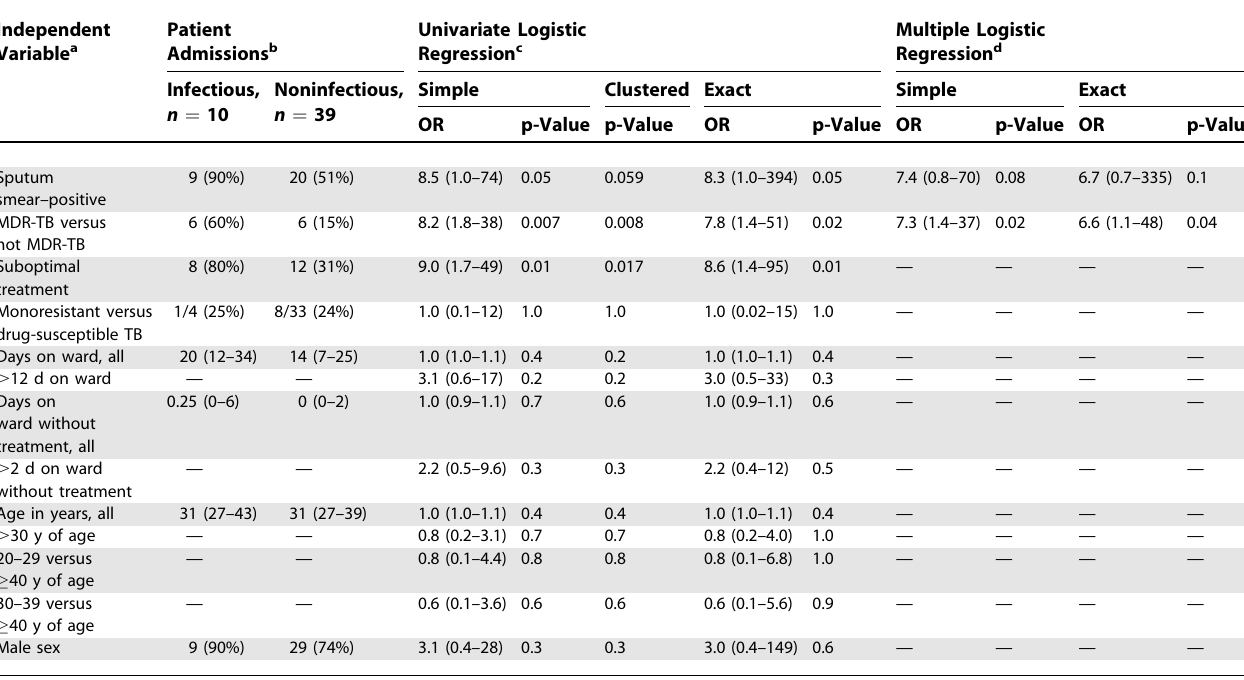
a For categorical independent variables, the number of cases (% of total in parentheses) is shown, and for continuousindependent variables, the median (IQR in parentheses) is shown. The primary analysis treated the independent variables ‘‘ Days on Ward ’’ and ‘‘ Days on Ward without Treatment ’’ and ‘‘ Age ’’ as raw, continuous variables. These primary analyses are complementedby secondaryanalyses (in parentheses)of eachof these variablesdividedinto categories aroundcutoffpointschosen to maximizethe likelihoodof theoutcome. Notethat the analysis of these independent variables as continuous or categorical data gave similar results. b Regression analysis was performed on putative determinants of infectiousness for the 49 ward admissions by pulmonary TB patients for which spoligotype patterns were available. Four patients accounted for the ten multiple admissions in this group. The first had MDR TB and was infectious on one admission when inadequately treated, and non-infectious on a subsequent admission when adequately treated. The second had four admissions: three were noninfectious with drug-susceptible TB that was first smear-positive and then smear- negative. The fourth admission was infectious, with acquired MDR-TB. The third patient had two noninfectious admissions separated by 4 mo with smear-positive inadequately treated monoresistant TB. The fourth patient had two noninfectious admissions separated by two months with smear-negative drug-susceptible TB. c The simple univariate regressions are shown with robust clustered SE estimated (to account for repeated hospitalizations by some patients) and with exact logistic regression (to account for the sample size). Note that simple, clustered, and exact univariate logistic regressions gave similar results. ORs (95% confidence intervals) are included. d Because of the sample size, only the three independent variables with clear associations with infectiousness (sputum-smear, MDR TB and suboptimal treatment) were considered for multiple regression analysis. In both simple and exact multiple logistic regression, the bestmodel by AIC criteria includedonly sputum-smear positivity and MDR TB (exact multiple logistic regression AIC ¼ 43.8). ORs (95% confidence intervals) are included. OR, odds ratio.